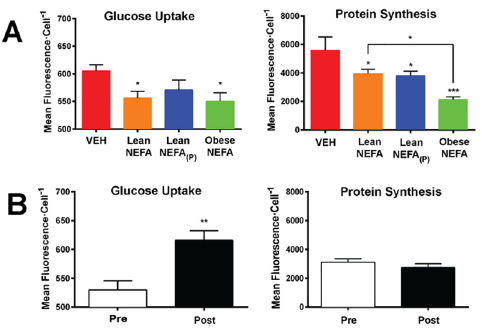
Fig 2. Concurrent assessment of glucose uptake and nascent protein synthesis in primary human myotubes reveals independent regulatory mechanisms. (A) Average responses for glucose uptake and protein synthesis. (B) Corresponding recovery experiments for myotubes exposed to Obese NEFA (Pre) and then incubated for an additional five days in normal growth media (Post). Data shown are means ± SE, n = 6 replicates/group, 10 − 3 cells/experiment, * P < 0.05, ** P < 0.01, and *** P < 0.001 by Student ’ s unpaired t-test or one-way ANOVA with Tukey ’ s posthoc